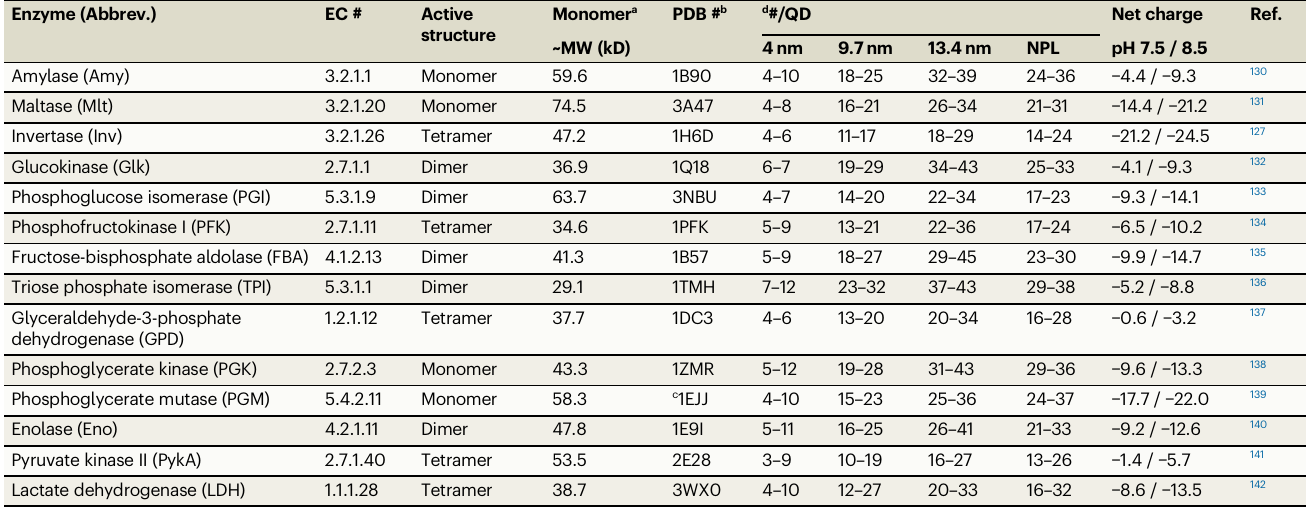
Table 1 | Enzymes utilized and some of their relevant properties Enzyme